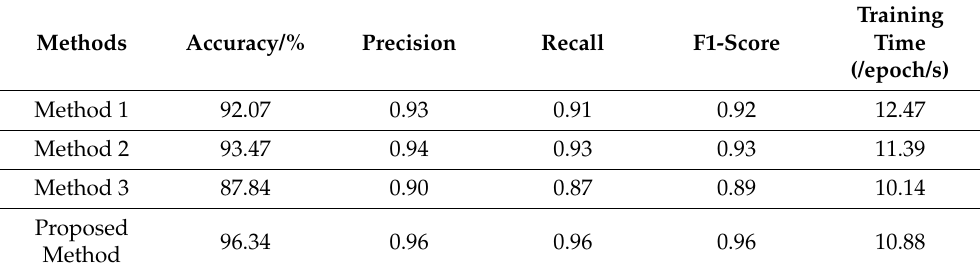
Table 3. Performance of different methods.